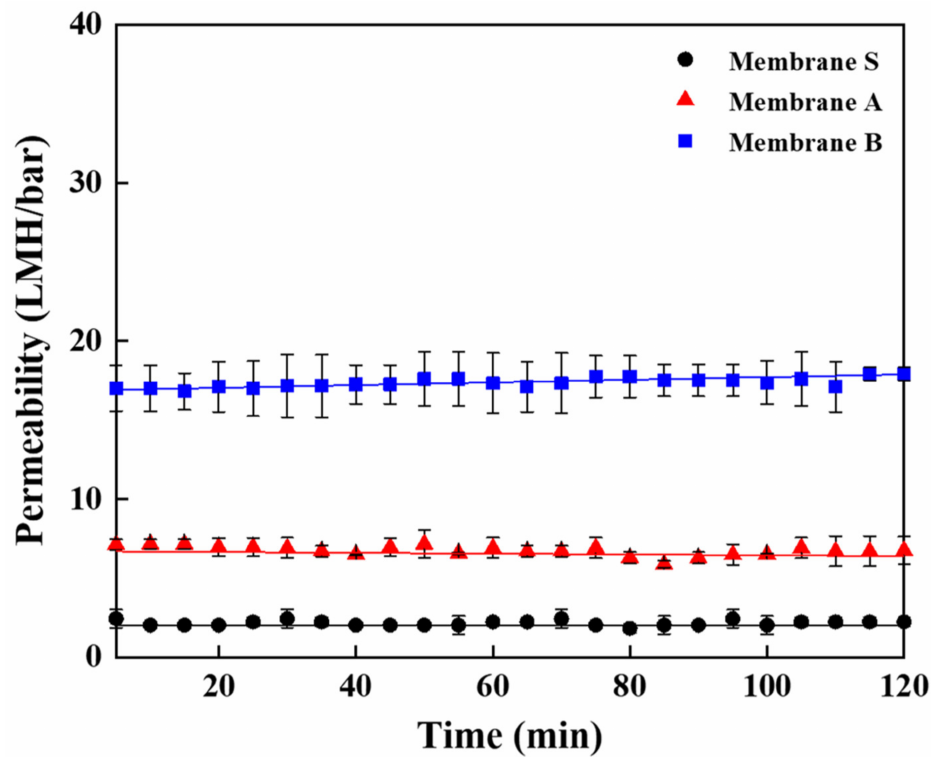
Figure 8. Pure water permeability curves by using the dead-end filtration system for γ -Al 2 O 3 tight ultrafiltration (UF) membrane S, A and B.